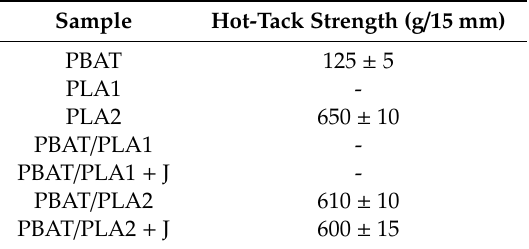
Table 4. Hot-tack measurements of the